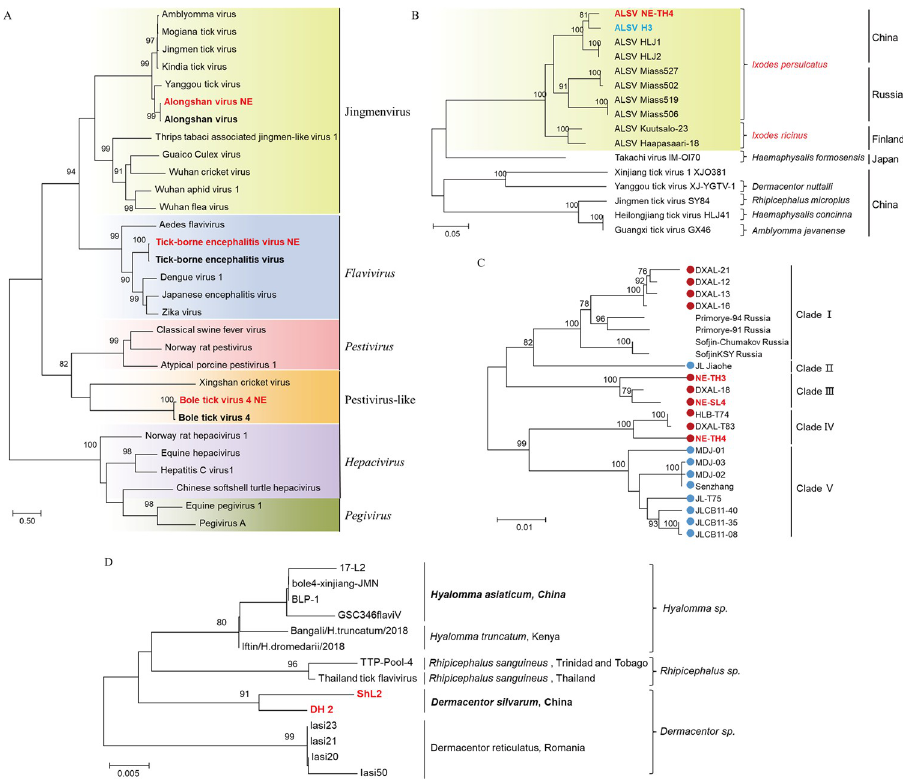
Fig 3. Phylogenetic analyses of flaviviruses. Phylogenetic trees were constructed based on the RdRp sequence of representative viruses in the family Flaviviridae (A), the segment 3 of ALSV and other representative viral strains in the Jingmenvirus group (B), the E protein of TBEV in NE China (C), and the RdRp of BLTV4 (D). All the viruses obtained in ticks here were highlighted in red. In panel A, closest referenced viruses were highlighted in bold font, and the virus genera or groups were marked with different colors of background. In panel B, ALSV isolated from humans were marked with blue. ALSV were highlighted with light green background. The host tick species of the viruses and the countries that the viruses discovered were also labeled. In panel C, TBEV isolated from CBM and XXAM were marked with blue-filled circles, while strains found in DXAM were marked with red-filled circles. In panel D, the strain names of BLTV4 were labeled. The host tick species and the countries that BLTV4 discovered were also marked. ALSV, Alongshan virus; TBEV, Tick-borne encephalitis virus; BLTV4, Bole tick virus 4. The accession numbers of the viral sequences are shown in S2 and S3